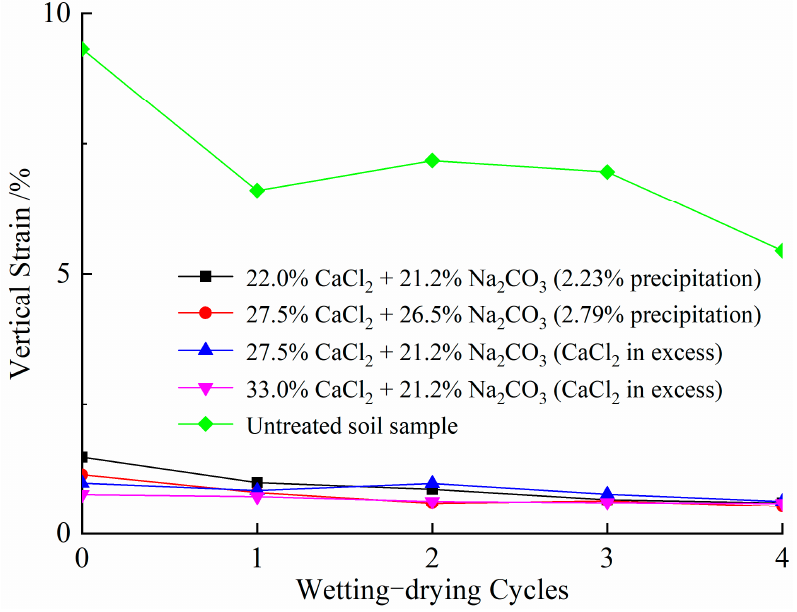
Figure 16. Variations in vertical strain versus wetting–drying cycles for natural and treated samples.